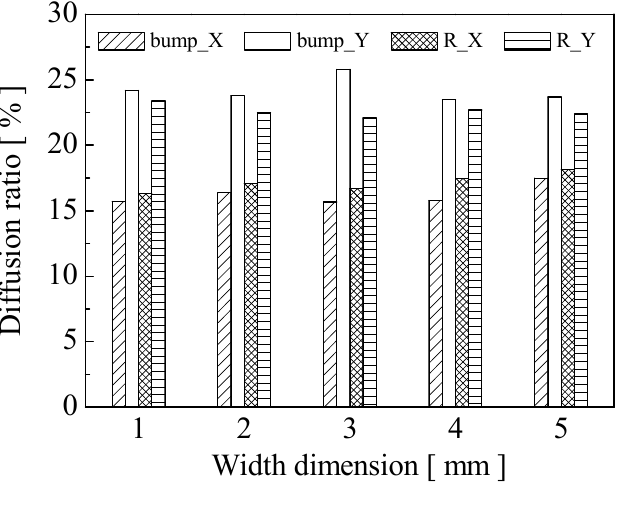
Figure 7. The printing diffusion ratios of the bump and resistance materials compared with original width. X and Y are parallel to and perpendicular to the printing directions,